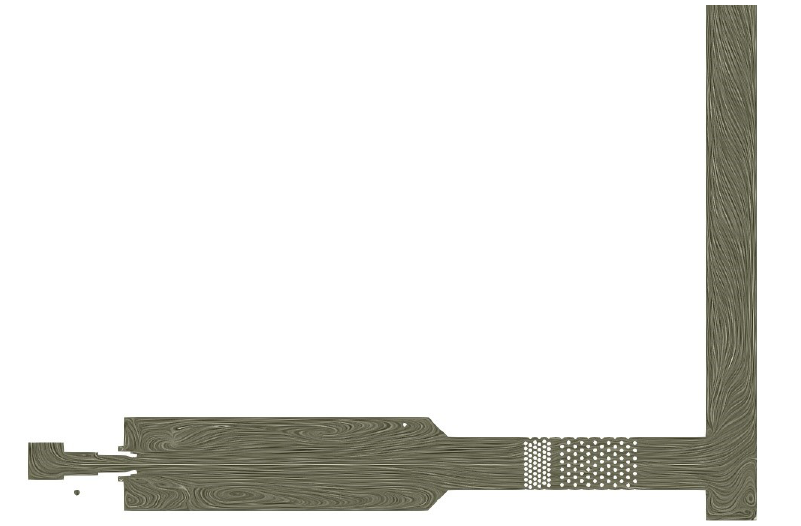
Figure 14. Flow streamlines in a vertical cut in the middle of OTSG.